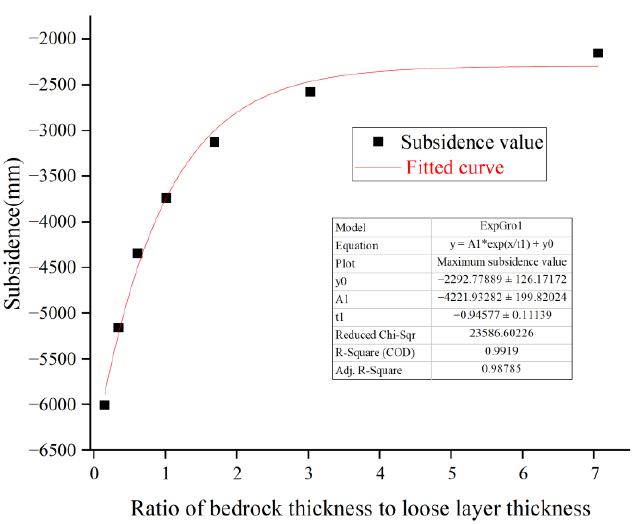
Figure 17. Relationship between surface subsidence values and the ratio of bedrock to loose layer.